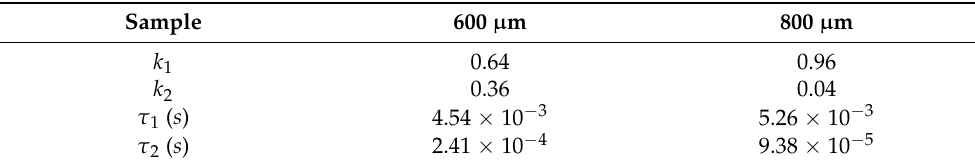
Table 1. Fitting results of τ 1 , τ 2 , k 1 and k 2 for SnS 2 film with 600 and 800 µ m electrode